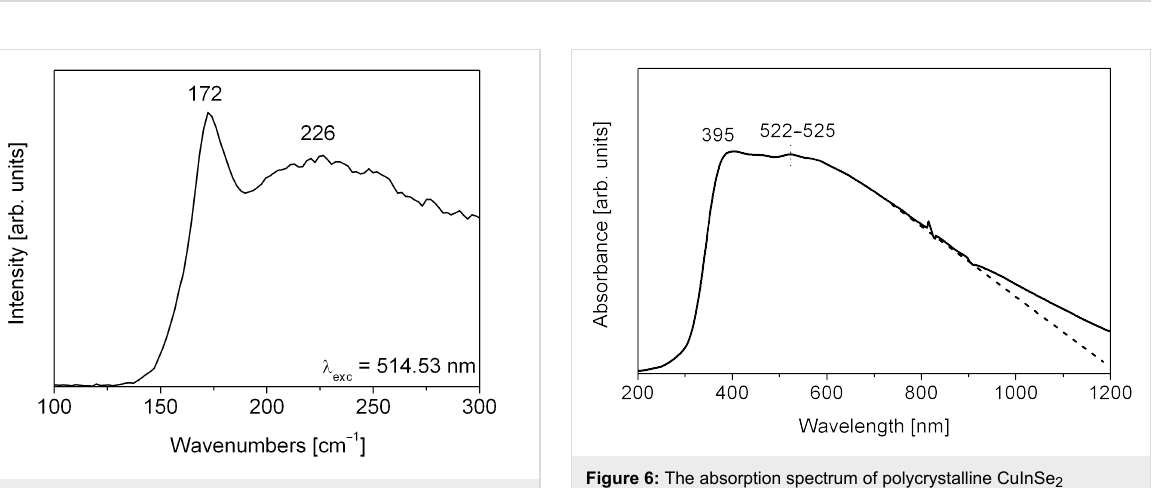
which corresponds to 2.36–2.38 eV. The artifact between 800 and 900 nm is due to the grating change of the two monochro- mators, which has gratings for each the NIR- and for the UV–vis-range. Some distinctive features can be observed in comparison with earlier reports on nanostructured CISe ma- terials. As a rule, CuInSe 2 CISe nanostructures of different